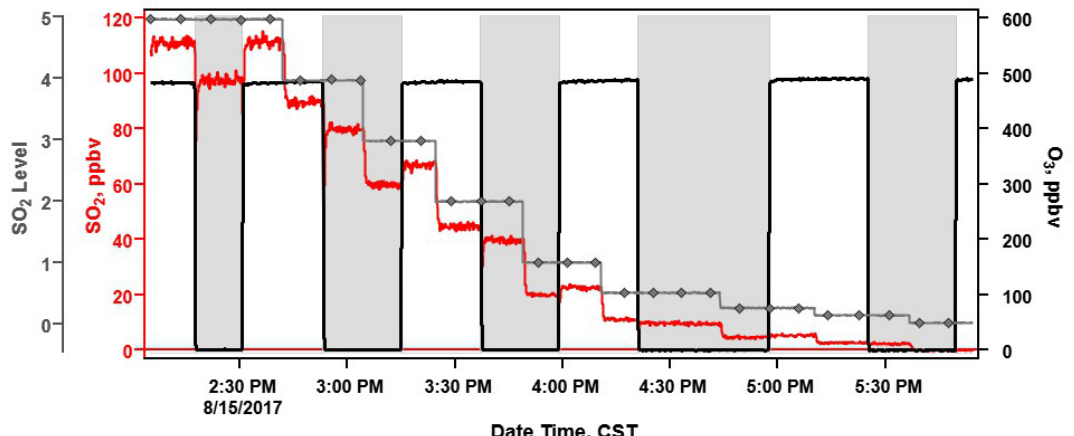
Figure 2. Time of series of a multipoint test of the O 3 filter removal efficiency and impact on SO 2 measurements taken by a Thermo 43 i -TL SO 2 analyzer. Changes in SO 2 dilution levels are indicated by the pink lines (diamond markers).